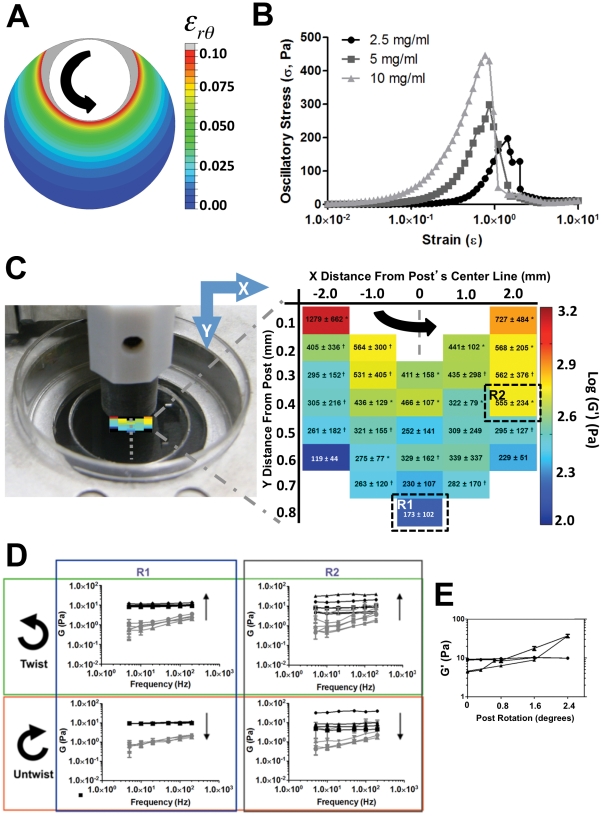
Microrheology within the strain gradient device.AMR within a 2.5 mg/ml fibrin gel confirms location-dependent stiffening with rotation of the post. (A) FEA of shear strain, , in response to a 2.4° rotation of the post. (B) Stress-strain curves for parallel plate rheology strain sweeps of 2.5, 5, and 10 mg/ml fibrin gels report nonlinear stiffening. (C) AMR map of G′ in a region near the post. In the first 0.1 mm from the post, changes in G′ are largest in the circumferential direction. For each colored block, G′ is compared to that of the unrotated state (*p<0.05; †p<0.15). (D) AMR for a single bead in either region R1 or R2 as specified in (C). AMR was performed as the post was rotated by 0.8, 1.6 and 2.4°, and then again as the post was rotated back. In region R1, no stiffening was observed as compared to R2 where G′ increased with rotation and then decreased as the post was rotated back to its original position. (E) Stiffening in region R2 (triangles) exhibited hysteresis where the material stiffened and softened along different paths as the post rotated. Note that the material returned to its original stiffness as measured by AMR. No change in stiffness was observed in region R1 (circles). Each point is the mean G′ of all measured frequencies. Errorbars represent the standard deviation of 5 sequential measurements.